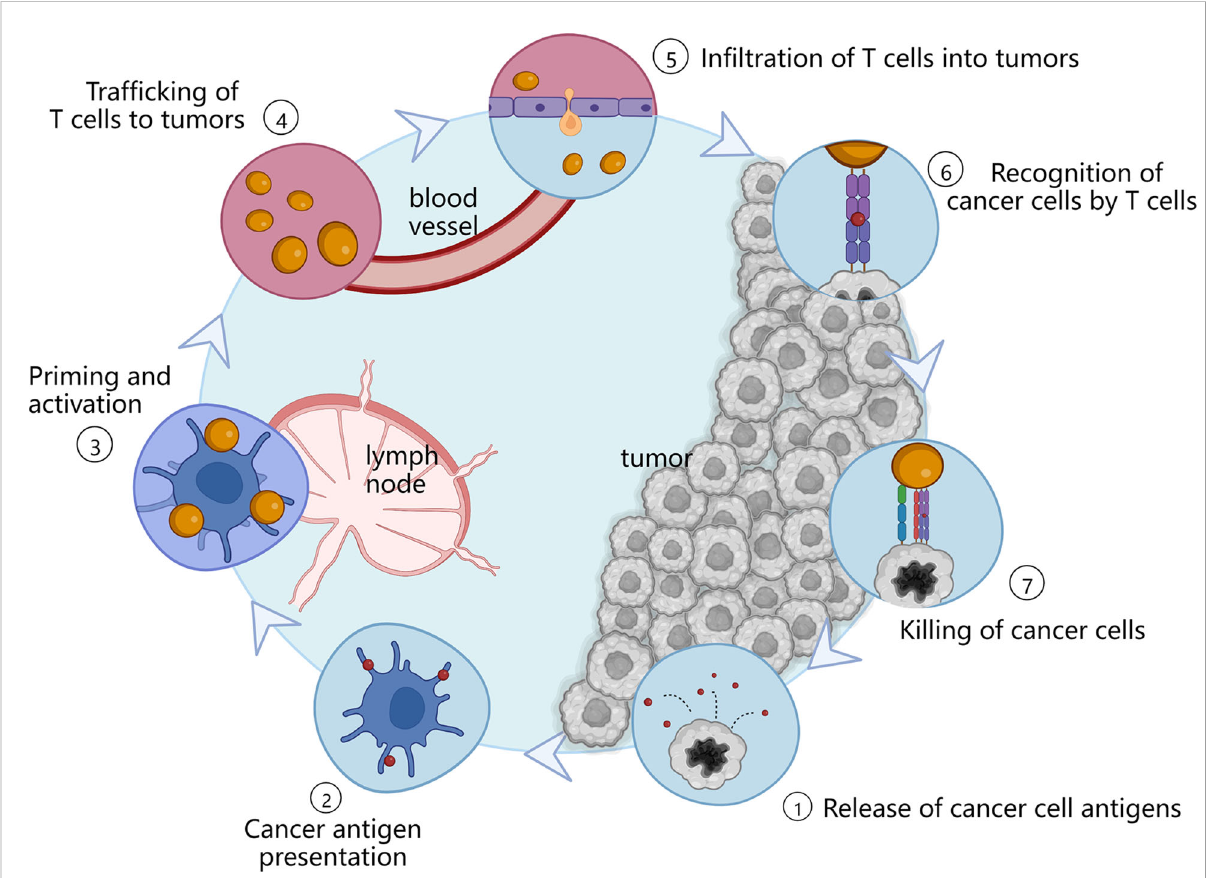
FIGURE 1 Immune actions in the cancer immunity cycle. APCs present antigens which are released by tumor cells to lymphocytes. And then, these antigens can be subsequently recognized by T cells located in the lymph nodes, thereby activating speci fi c immune responses to the tumor